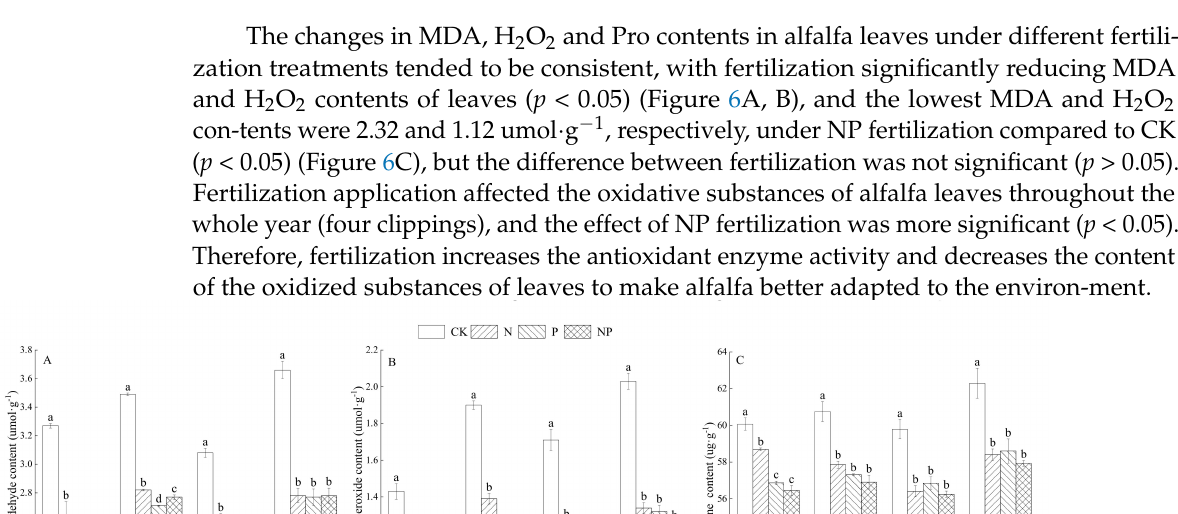
Figure 5. Effect of nitrogen and phosphorus treatments on antioxidant enzyme activity of ( A ) Super-oxide dismutase activity, ( B ) peroxidase activity and ( C ) catalase activity of alfalfa leaves. Different letters above column indicate significant difference among treatments with different ( p < 0.05).